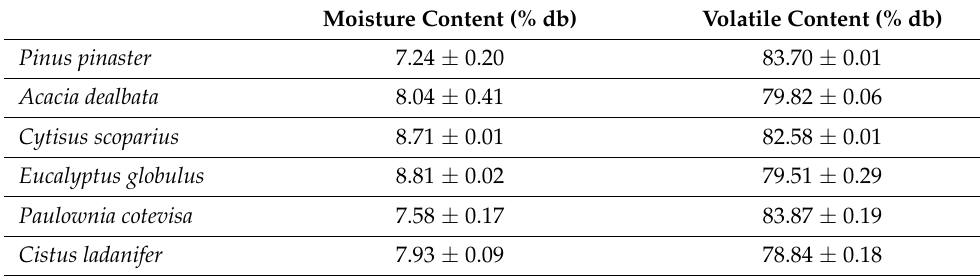
Table 2. Moisture content and volatile content of the experimental pellets.